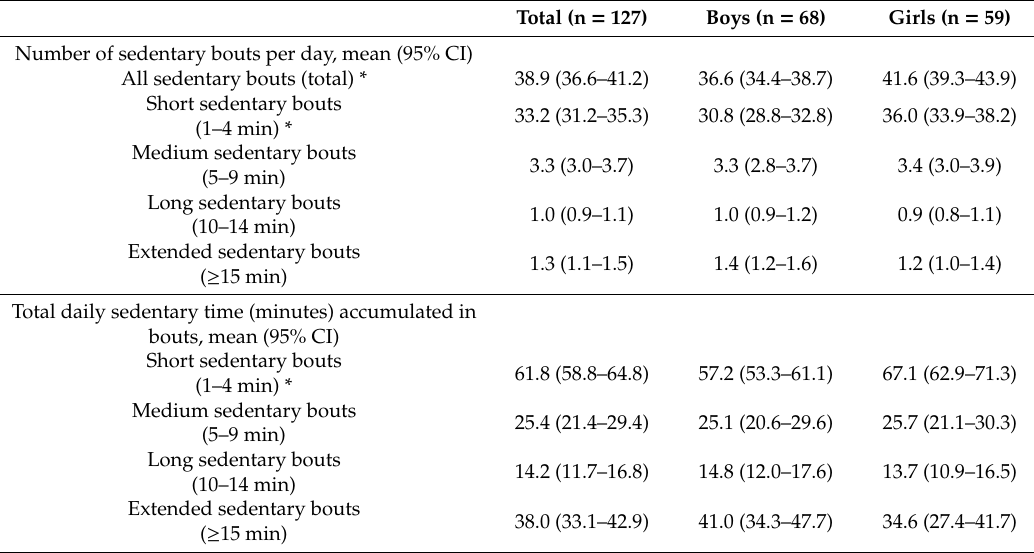
Table 2. Daily number of sedentary bouts and sedentary time in bouts by child